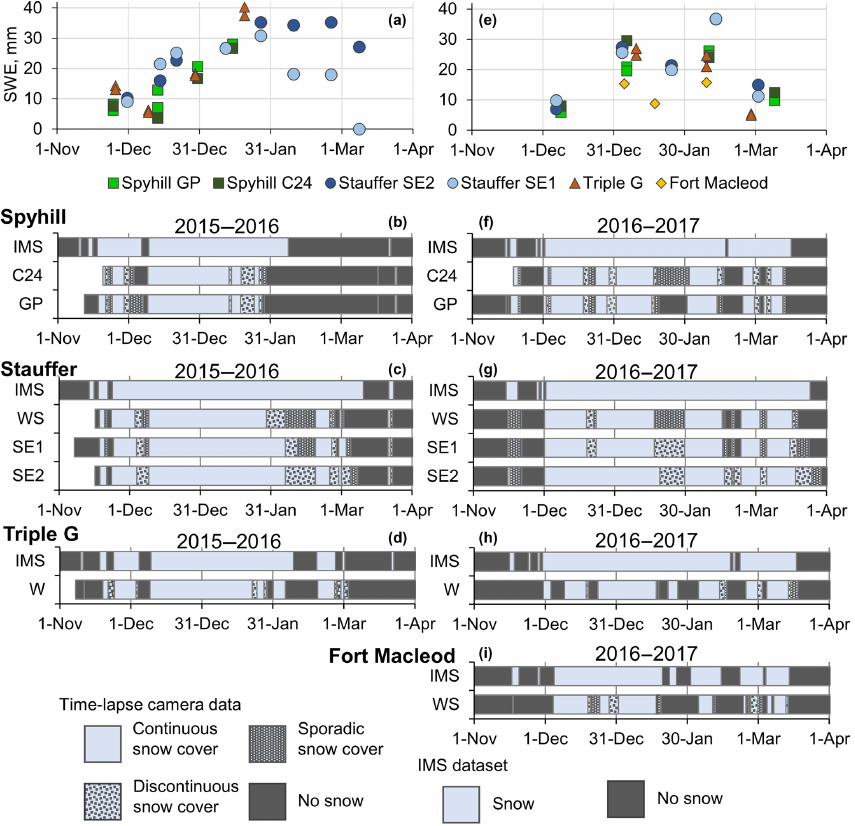
Figure 4. Measured SWE and snow-cover conditions at the study sites, derived from the IMS dataset at 4km resolution (National Ice Center, 2008a) and observed in time-lapse photos in winters of 2015–2016 (left) and 2016–2017 (right). Location of the sub-sites is shown in Fig. 3. WS – weather station.